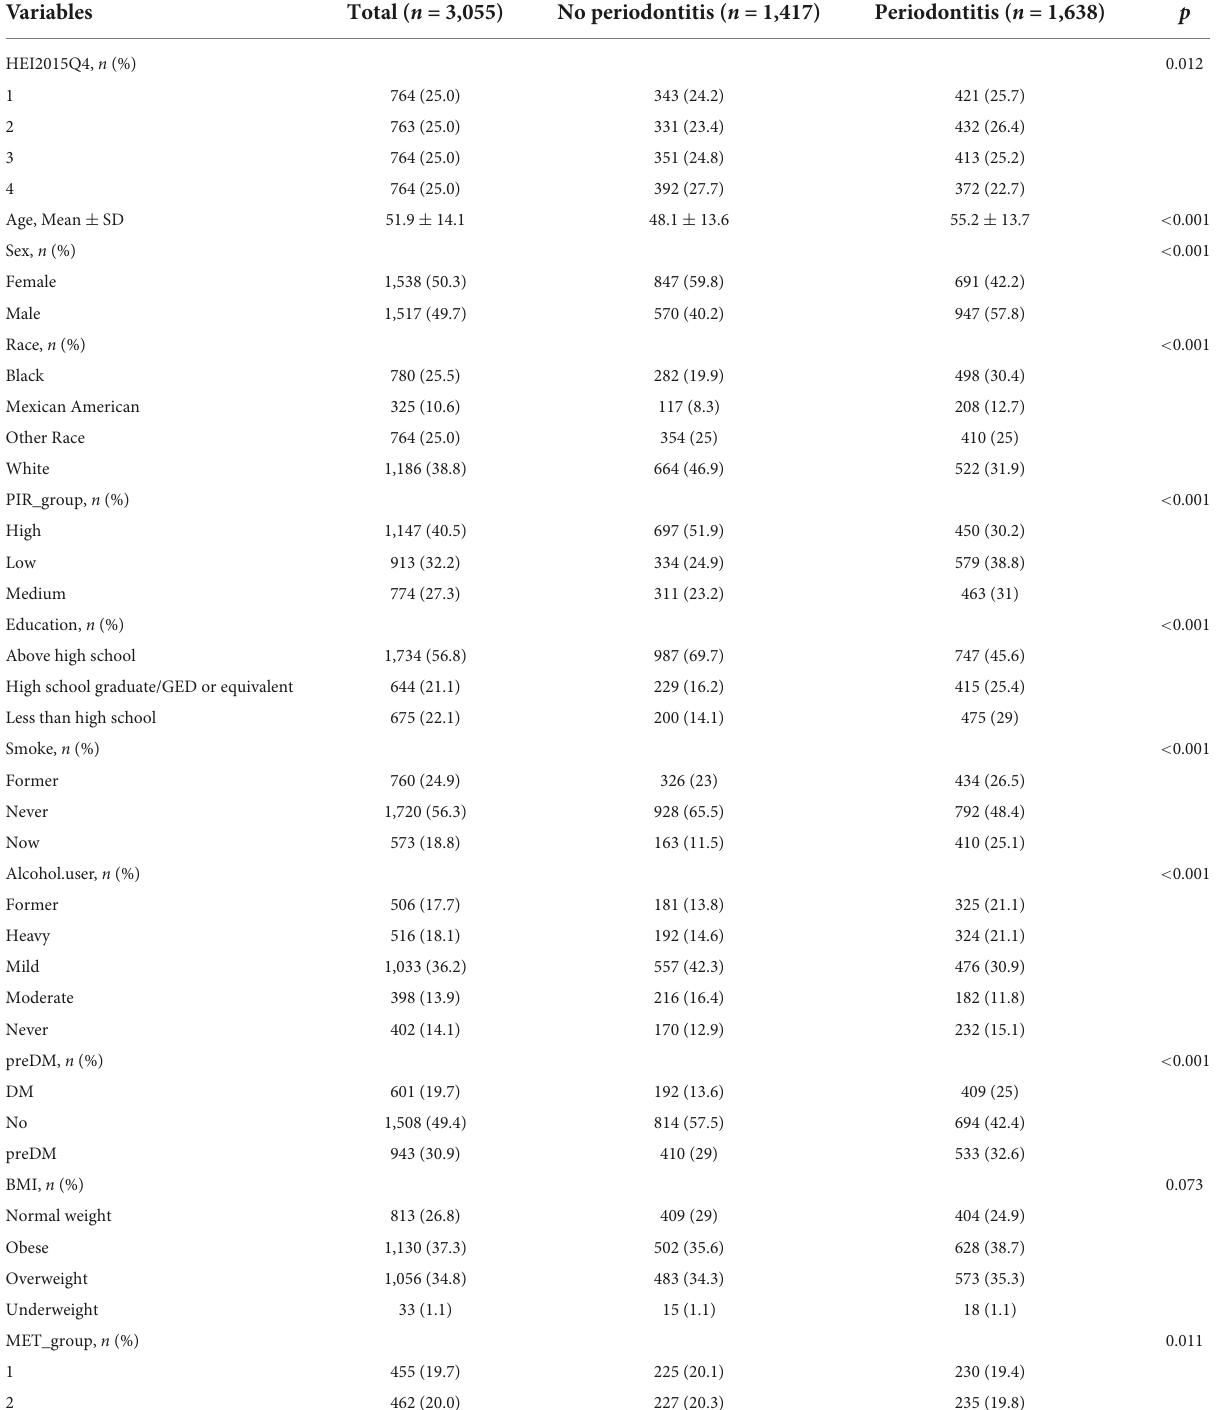
TABLE 2 Characteristics of the overall target population according to